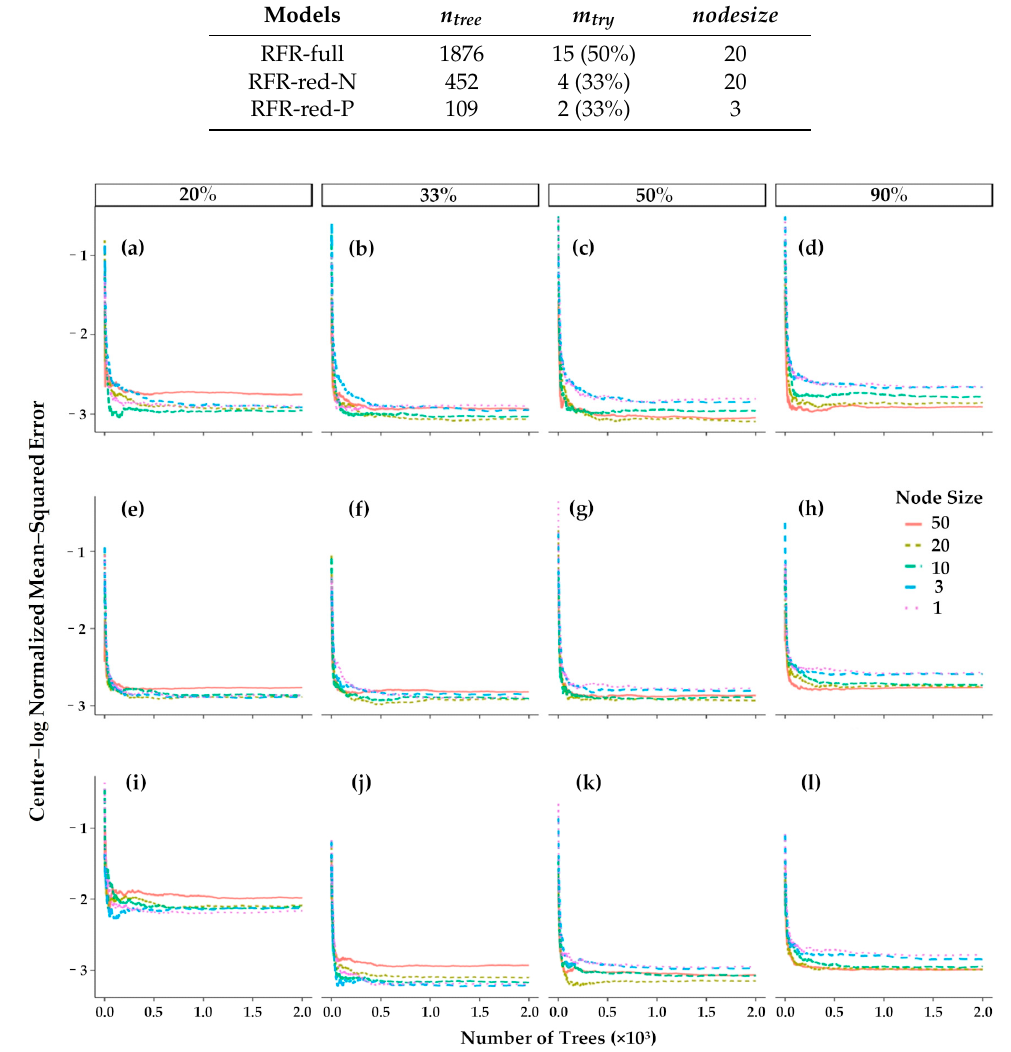
Figure 5. Center-log normalized out-of-bag (OOB) error curves for models with different hyperparameter configurations. To better illustrate the figure, all of the normalized errors were scaled using the equation y = ln(err − 0.5). Panel ( a – d ), ( e – h ) and ( i – l ) correspond to the RFR-full, RFR-red-P and RFR-red-N, respectively. The percentages on top of each column are the percentages of total number of variables that are available for splitting at each tree node. Curves in different colors represent different minimal size of leaf nodes.